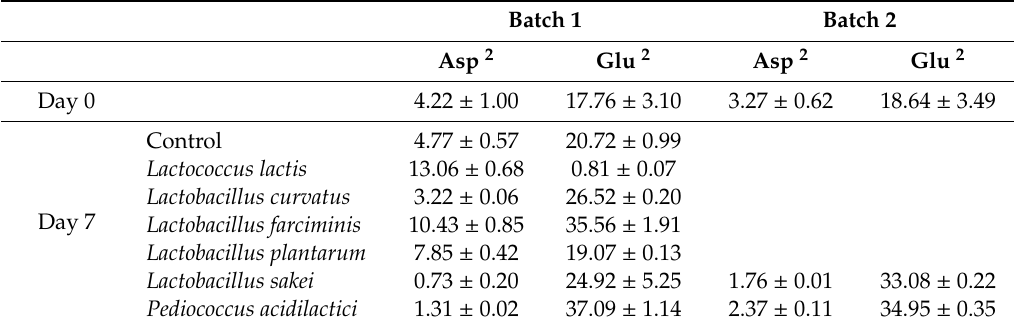
Table 2. Changes in the contents of the free amino acids aspartic acid (Asp) and glutamic acid (Glu) during fermentation of a mealworm paste without the addition of the curing agent sodium nitrite 1